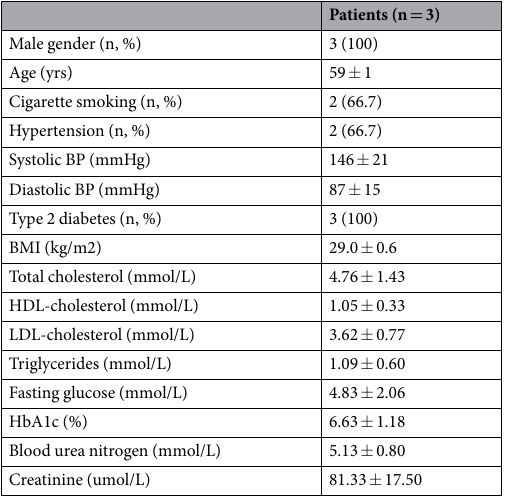
Table 1. Baseline characteristics and biochemical measurements of atherosclerosis